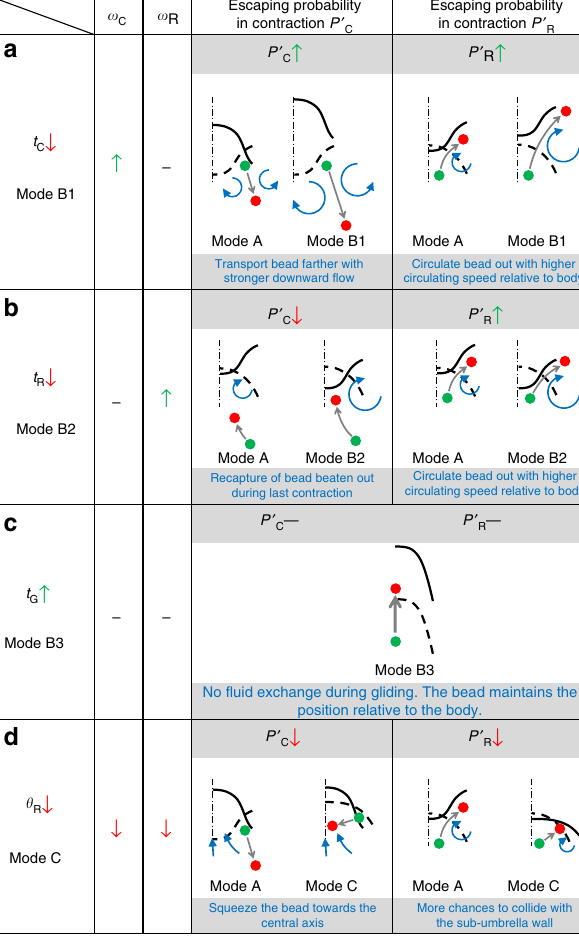
Fig. 6 The mechanisms of changing the escaping probability by changing the robot ’ s kinematic parameters. The comparisons between Modes B1, B2, B3, and C with Mode A are shown in a - d , respectively. The green up arrow, the red down arrow, and the black line indicate, respectively, the increase, decrease, and no change in kinematic parameter value or probability. The dashed and solid curves indicate, respectively, the positions of the robot body at the last and the current phases. The green and red dots indicate, respectively, the positions of the object at the last and the current